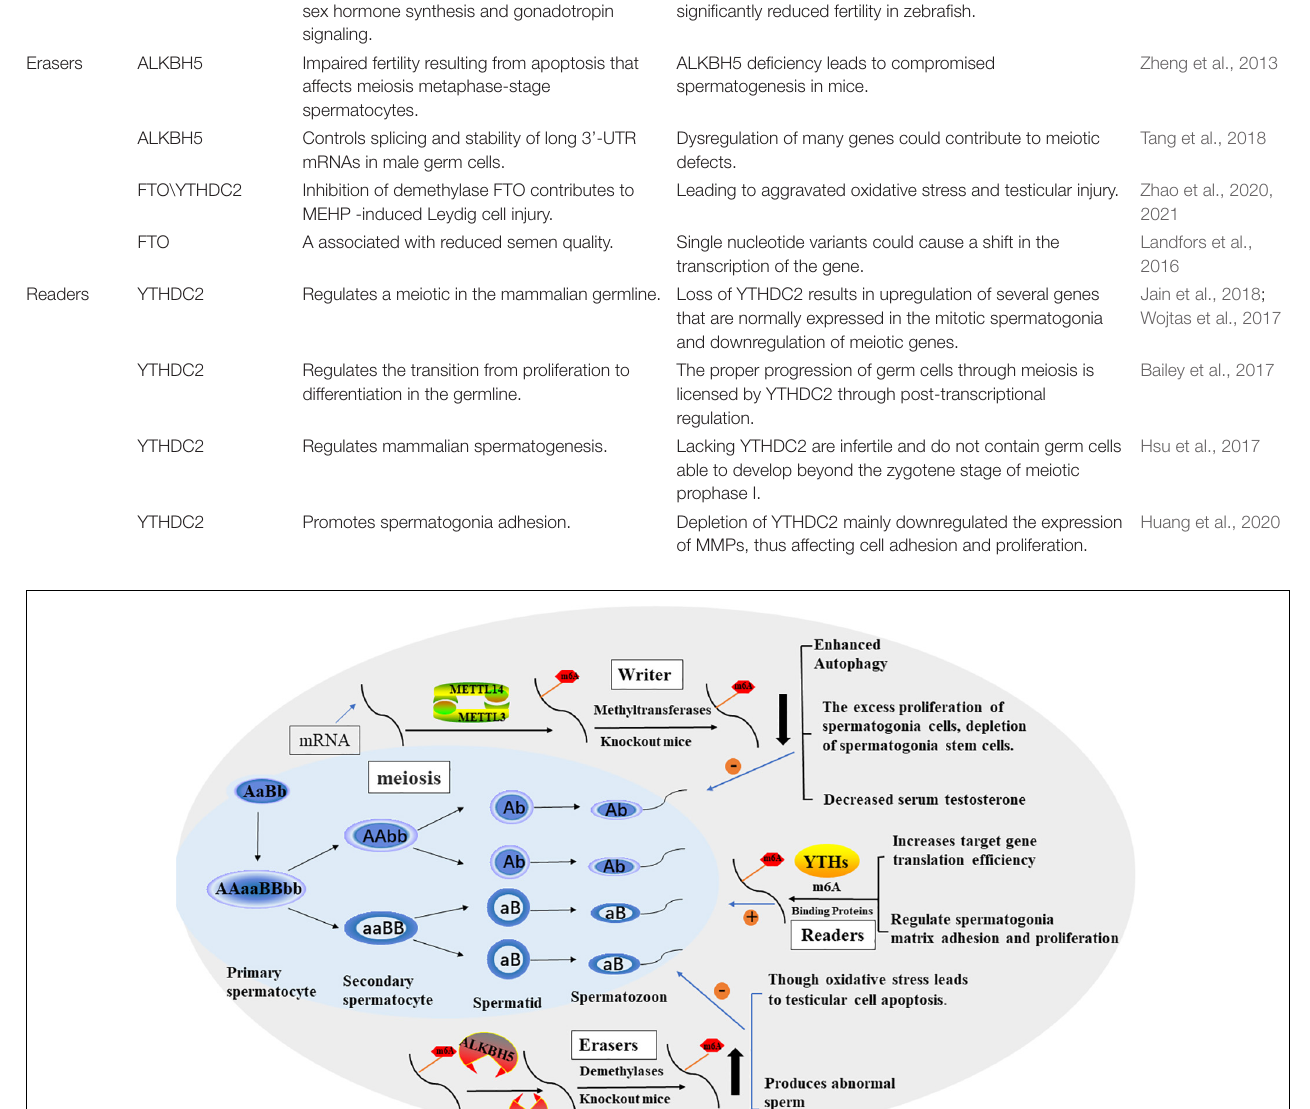
germ cell-specific inactivation of METTL3 and METTL14 can lead to excessive proliferation of spermatogonial cells, which would, in turn, result in depletion of spermatogonial stem